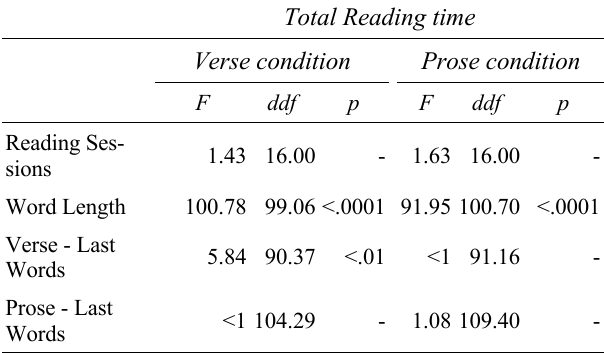
Table 5. Mixed model parameters for the separate analysis (verse vs. prose conditions) for total reading time (lexical